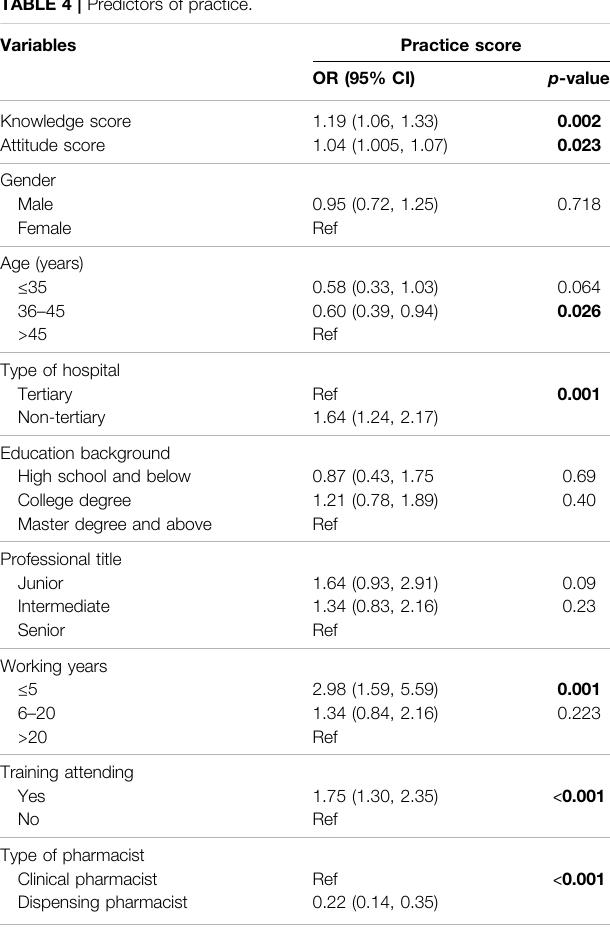
TABLE 4 | Predictors of practice.